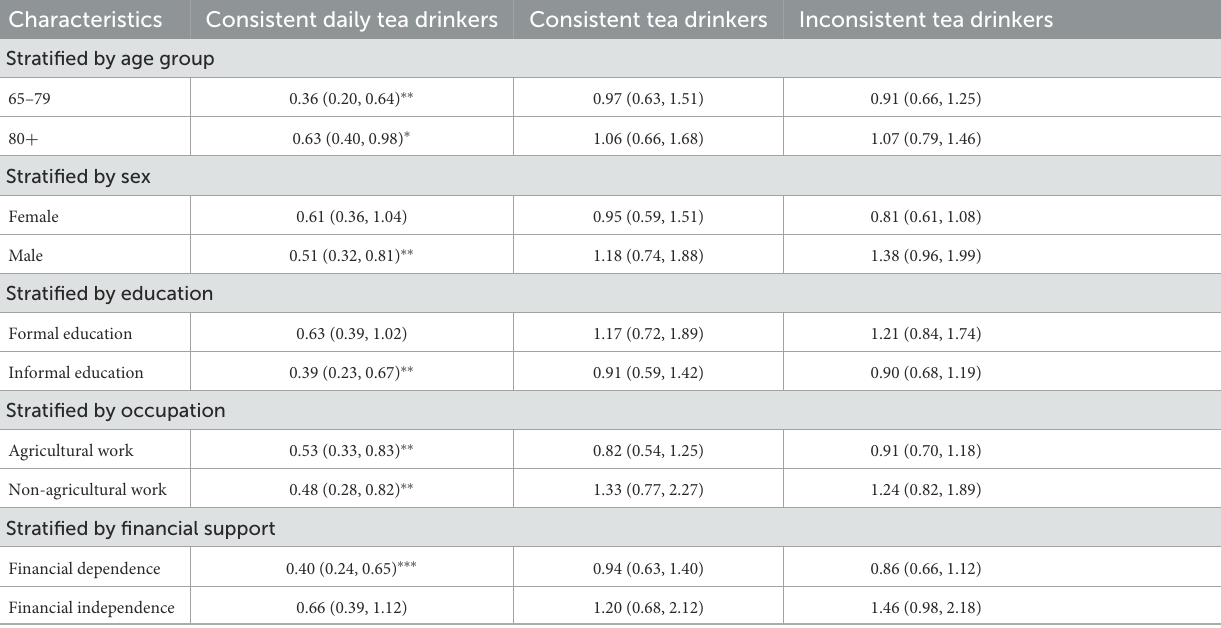
TABLE 3 The association between tea consumption and frailty stratified by age, sex, and socioeconomic status. Characteristics